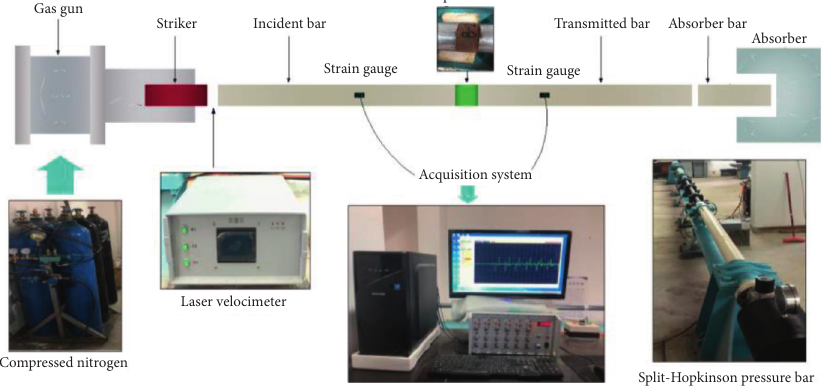
Figure 1: SHPB test system.